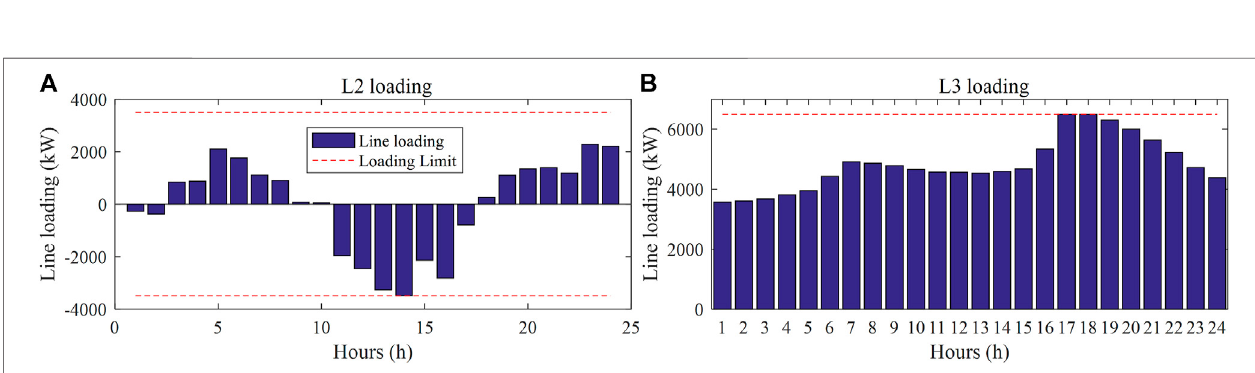
FIGURE 7 | (A) Line loading of L2 after congestion management in scenario 1, (B) line loading of L3 after congestion management in scenario 1.